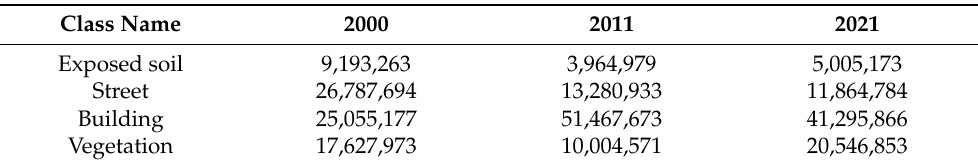
Figure 5. ( a ) Satellite image of 2021. Based on the morphological analysis, it is clear that the inter- vention has reached its stage of maturity; ( b ) implementation of green infrastructure is almost com- plete, and there are few areas marked as exposed soil. Table 2. The total area occupied by each of the respective classes over time. Results were obtained with supervised classification.